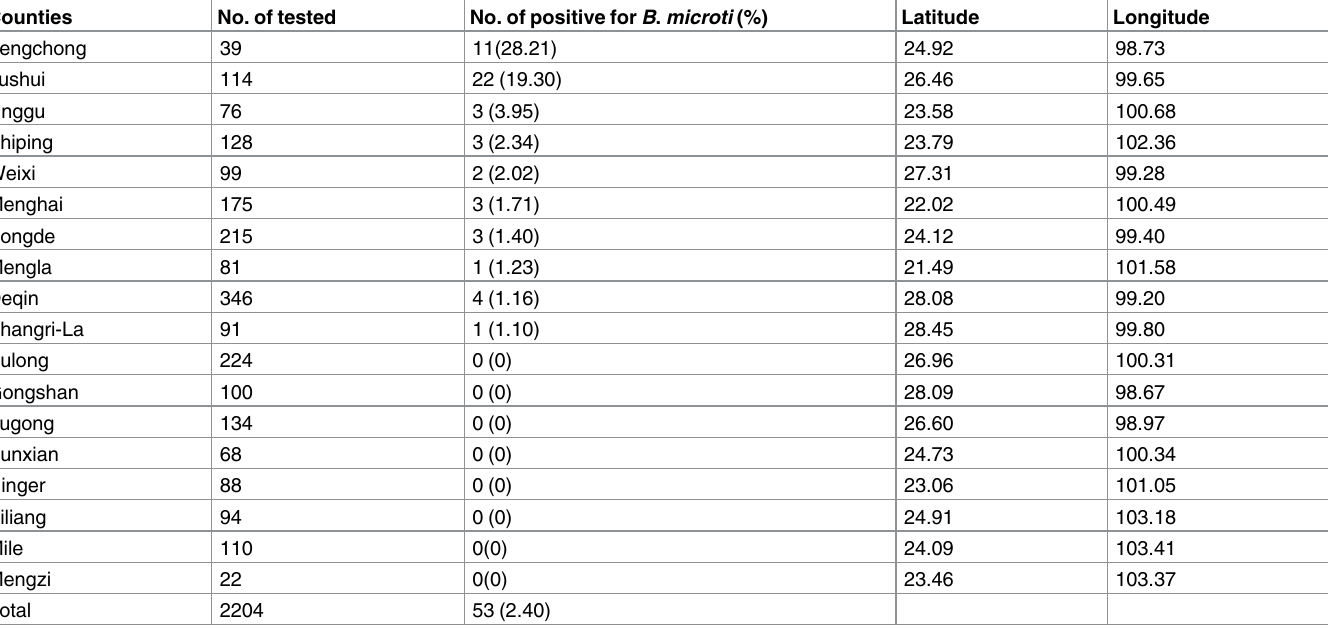
Table 1. Prevalence of B . microti in small mammals from different survey